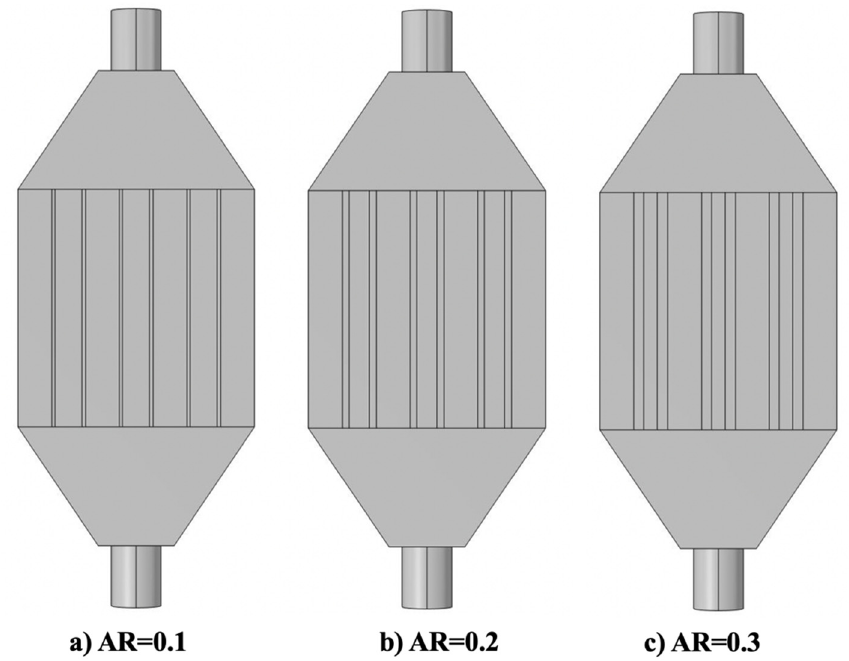
Figure 2. Models with a different aspect ratio.